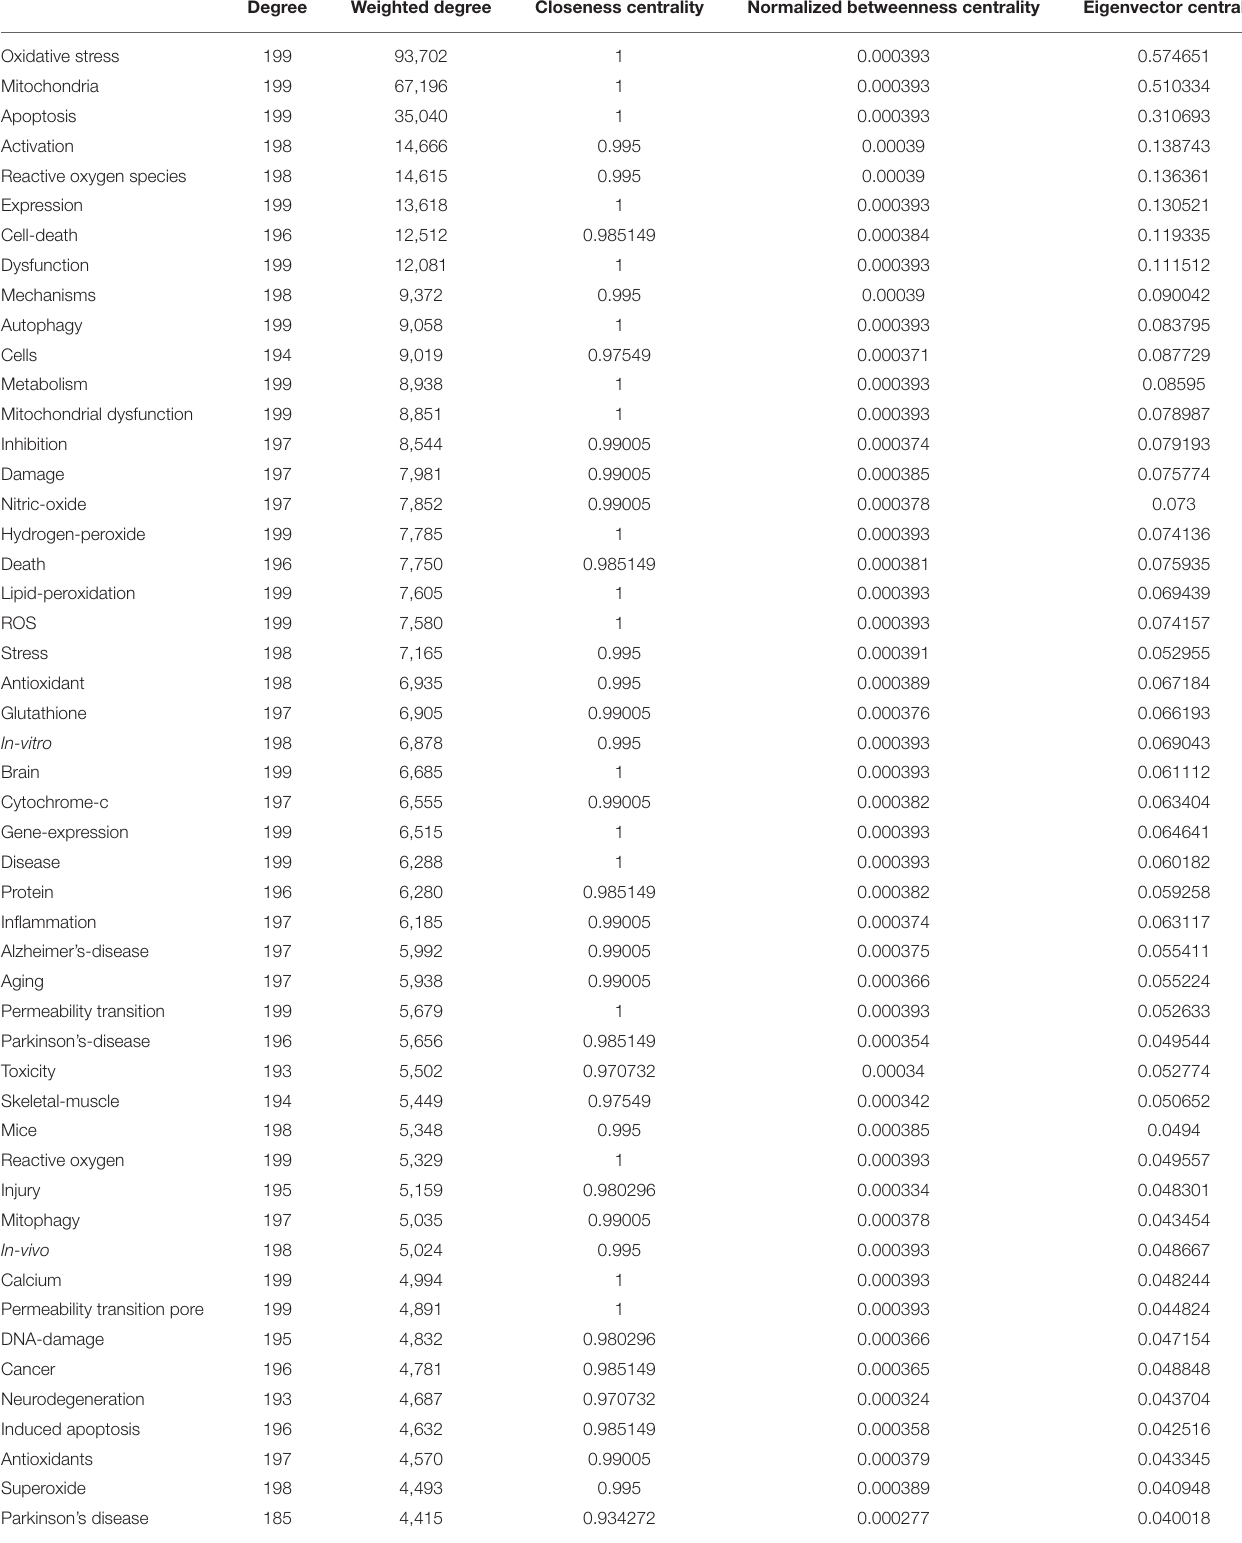
TABLE 2 | Network metrics for top 50 co-occurrence keywords associated with oxidative stress & mitochondria. Degree Weighted degree Closeness centrality Normalized betweenness centrality Eigenvector